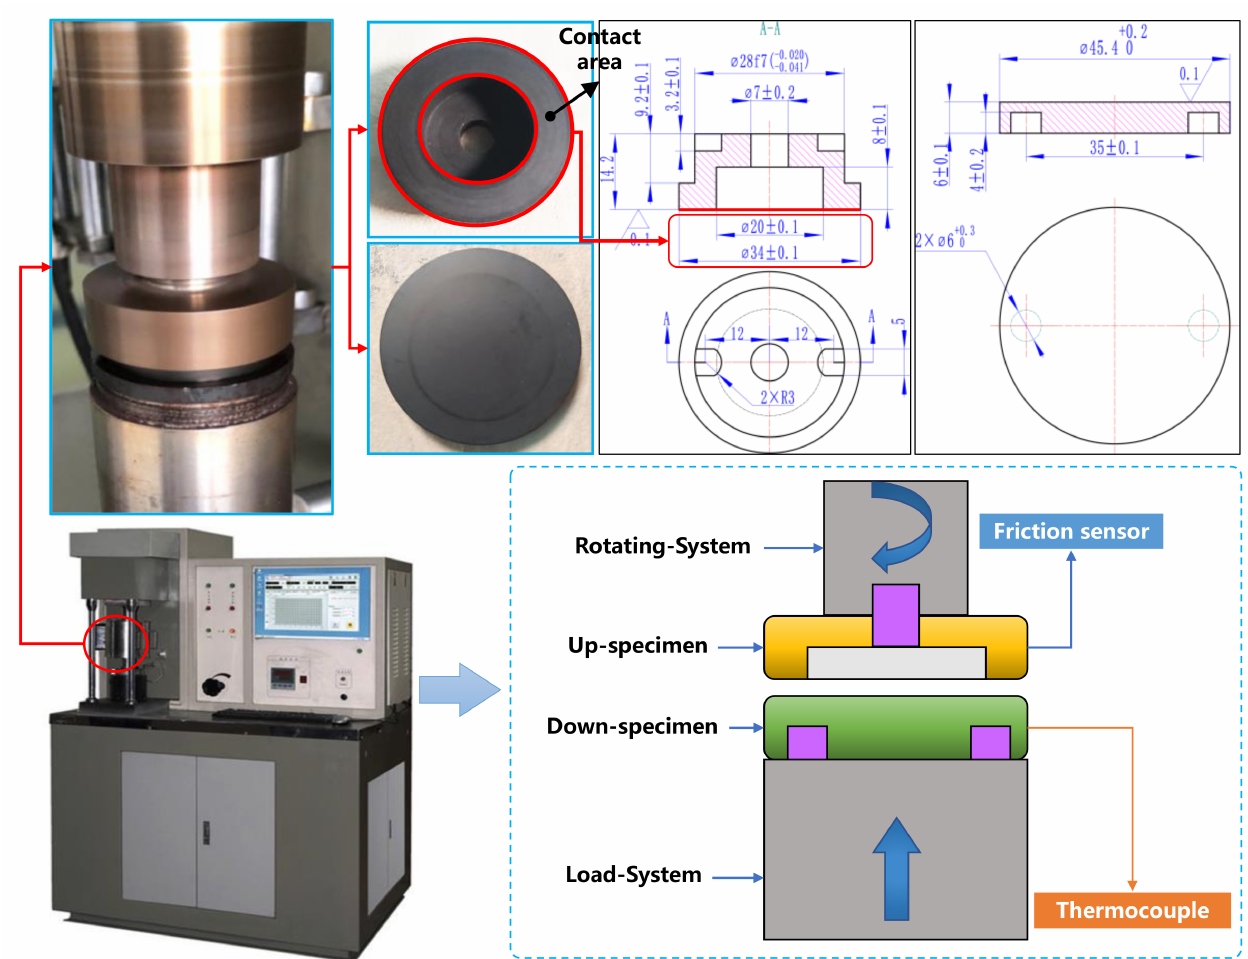
Figure 1. Friction and wear testing apparatus and specimen